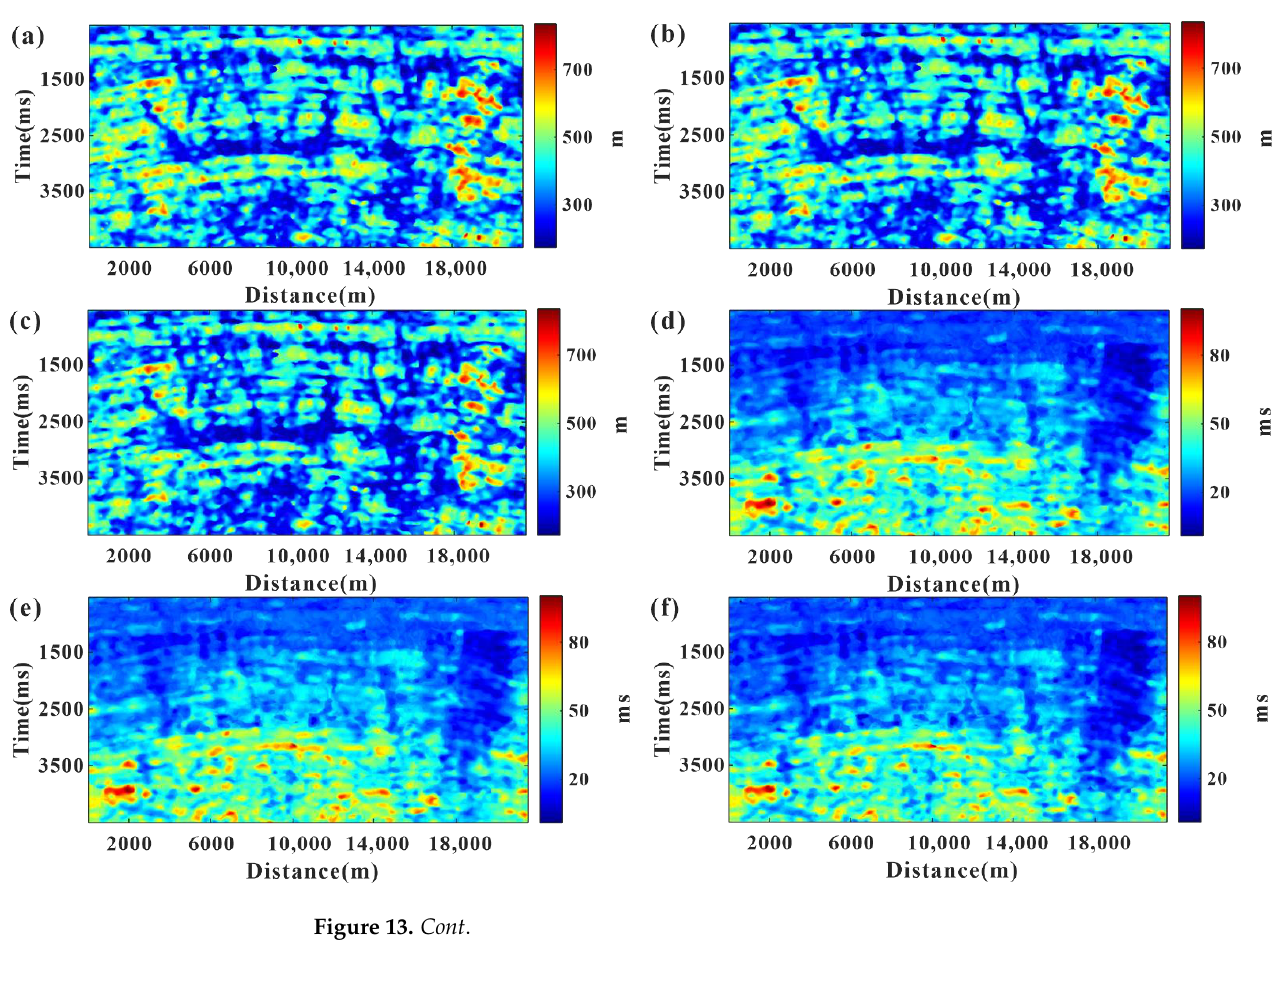
Figure 12. Stacked seismic data with different center angles: ( a ) 7°, ( b ) 15°, ( c ) 24°.